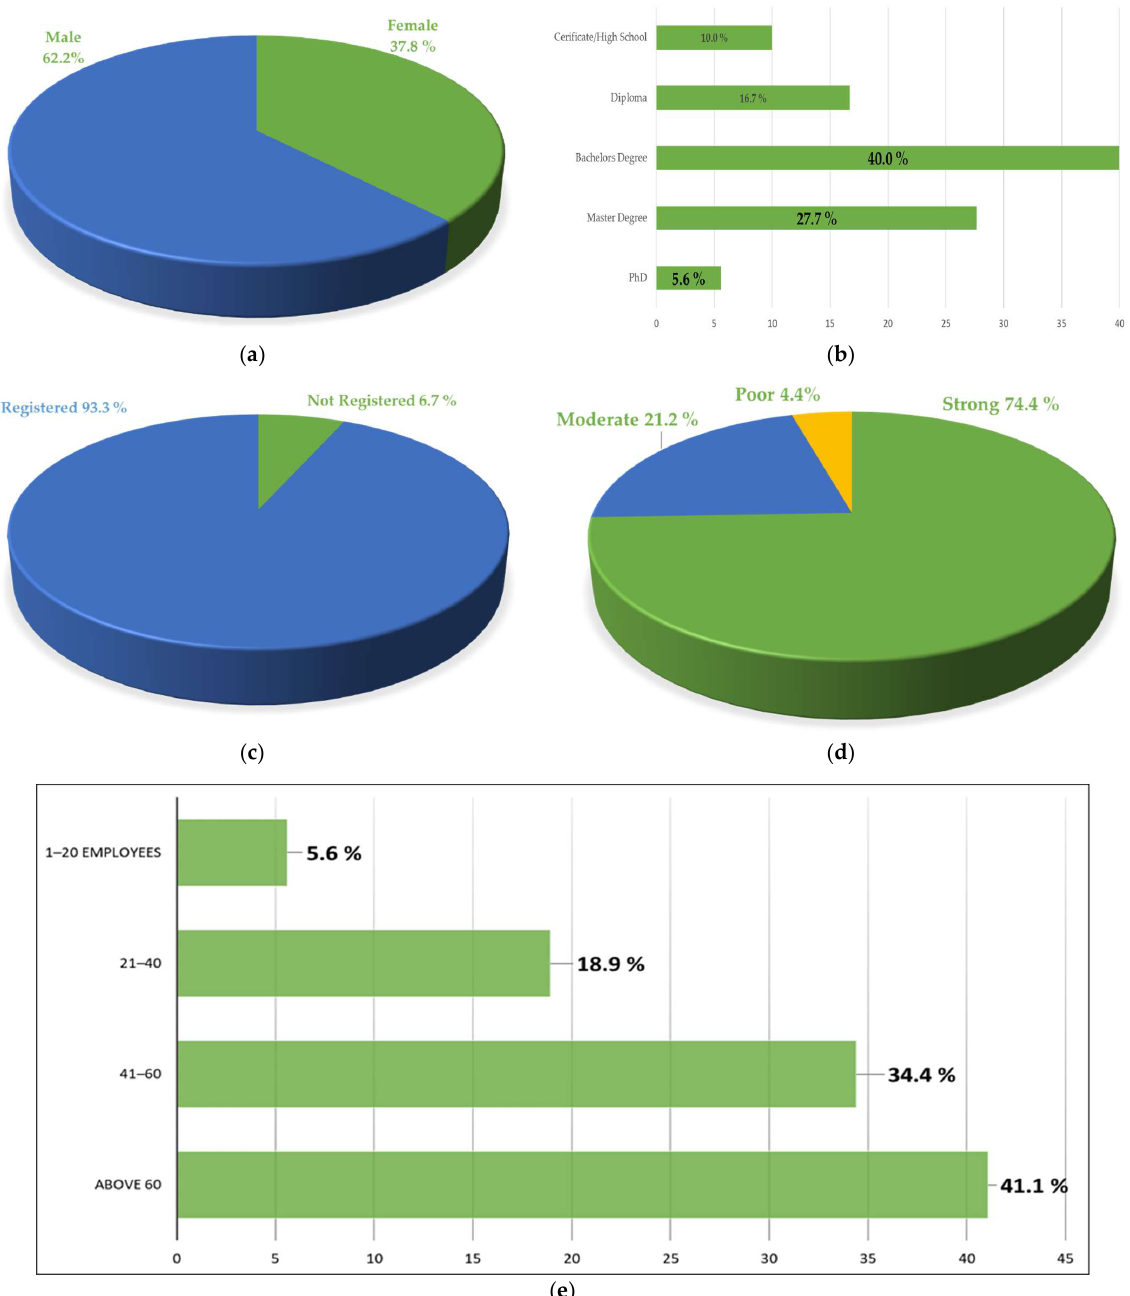
Figure 2. Demographic characteristics. Source: Authors’ own work (2022). ( a ) Gender of respondents. ( b ) Education of respondents. ( c ) Registration status of respondents. ( d ) Relationship with distributor. ( e ) Number of employees.